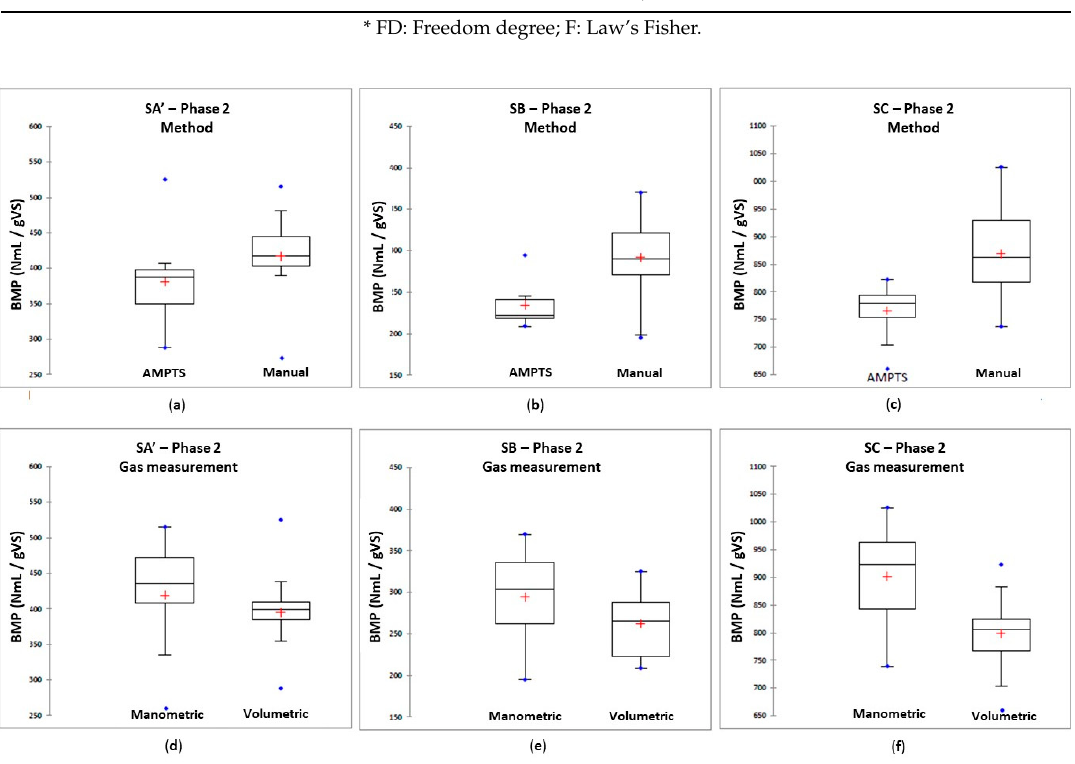
Table 10. Size of ANOVA with 4 factors for SA’, SB and SC. Factor